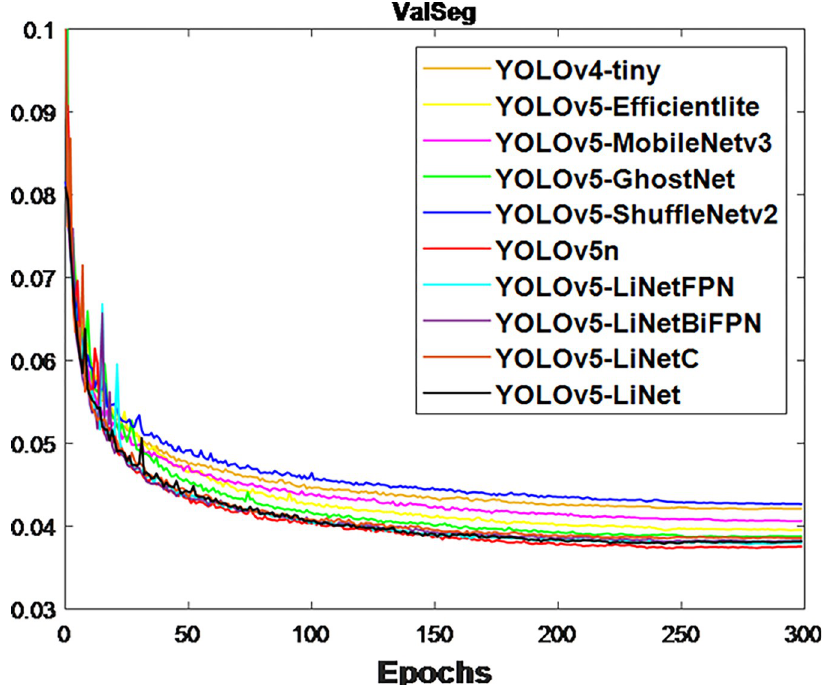
Fig 4. Output for segmentation validation loss.